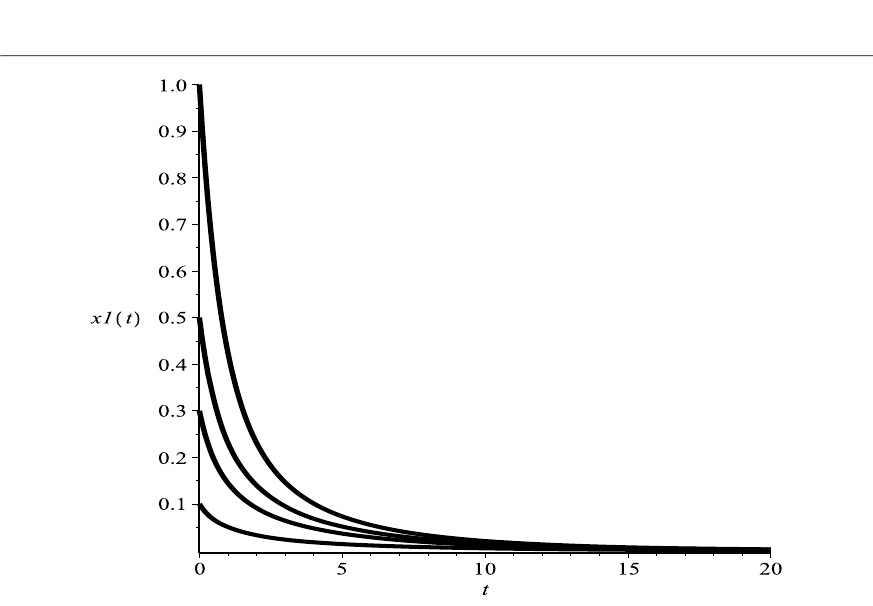
Figure 2 Dynamic behaviors of the first component x 1 ( t ) of system (4.1), here we take d = 1/4 and the initial conditions ( x 1 (0), x 2 (0), y (0)) = (0.5,0.5,0.5), (0.1,0.1,0.1), (1,1,1), and (0.3,0.3,0.3),